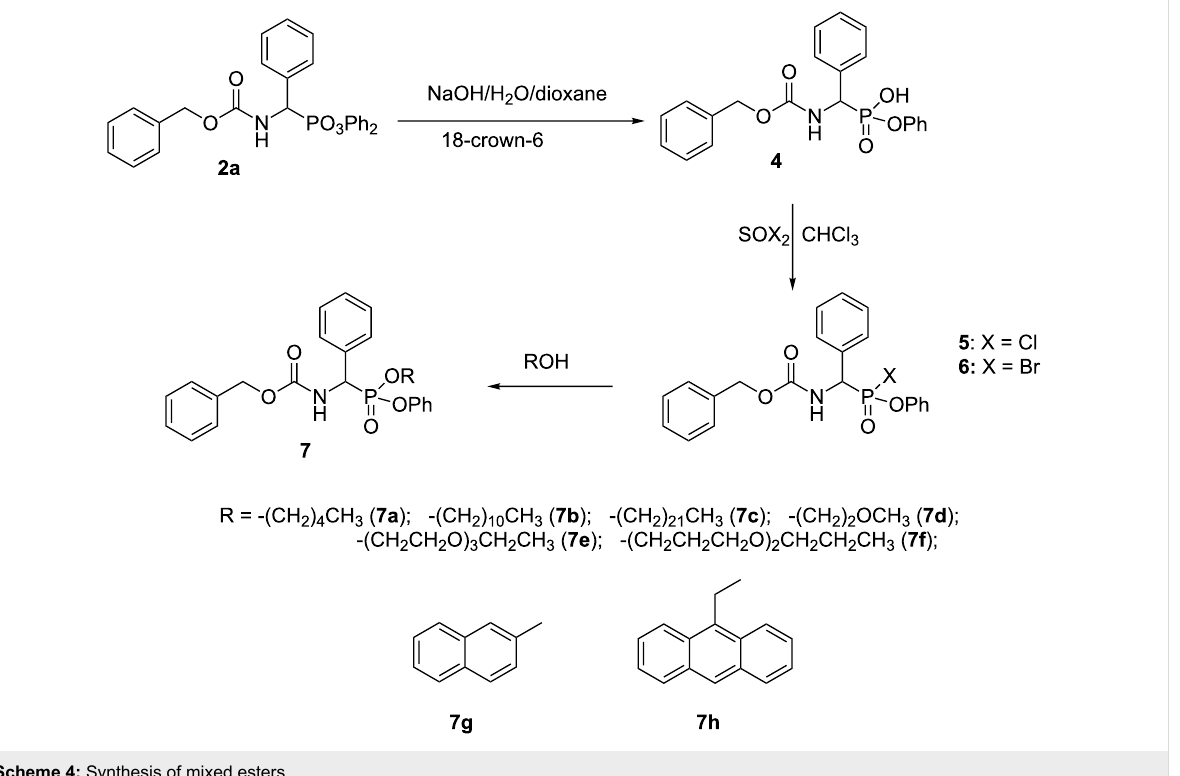
Scheme 4: Synthesis of mixed